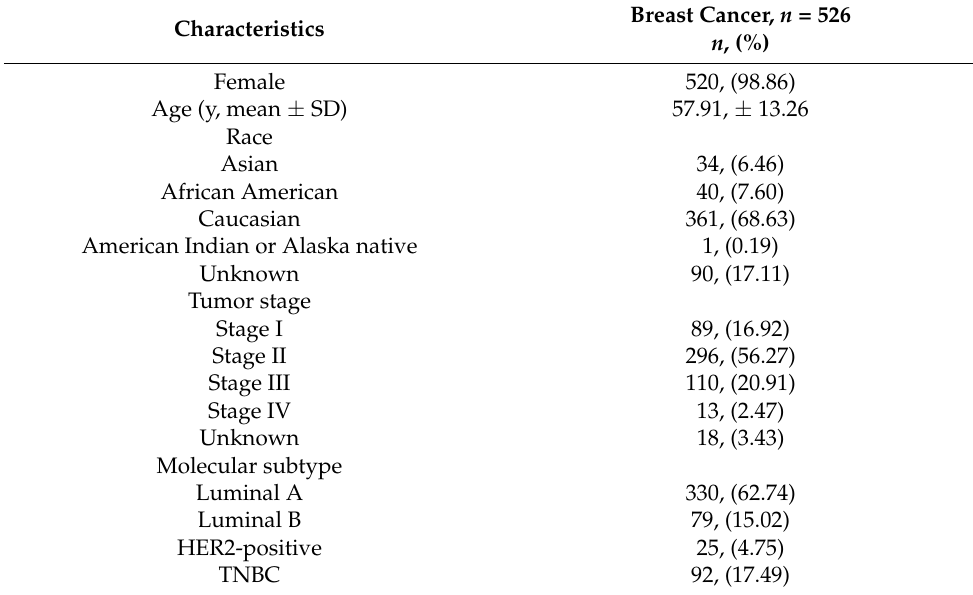
Table 1. Clinical data of enrolled individuals in the current